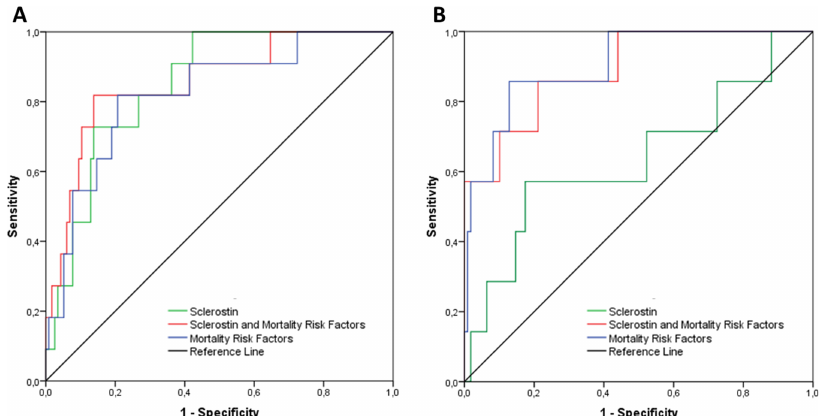
Fig 3. ROC curves testing the usefulness of sclerostin levels as predictors of mortality using a multiple logistic regression model. (A) ROC curve for cardiovascular mortality; (B) ROC curve for non-cardiovascular mortality. Sclerostin (A: AUC 0.849, 95% CI = 0.758–0.940, p < 0.001; B: AUC 0.773, 95% CI = 0.651–0.896, p < 0.001). Sclerostin and mortality risk factors (age, presence and duration of diabetes, sex, prevalent CVD, pIMT, tobacco use, hypertension and eGFR) (A: AUC 0.856, 95% CI = 0.736–0.975, p < 0.001; B: AUC 0.869, 95% CI = 0.788–0.949, p < 0.001). Mortality risk factors (A: AUC 0.823, 95% CI = 0.694–0.952, p < 0.001; B: AUC 0.828, 95% CI = 0.740–0.915, p < 0.001). ROC: receiver operating characteristic curve; AUC: area under the curve; CVD: cardiovascular disease; pIMT: pathological intima media thickness; eGFR: estimated glomerular filtration rate; CI: confidence interval.